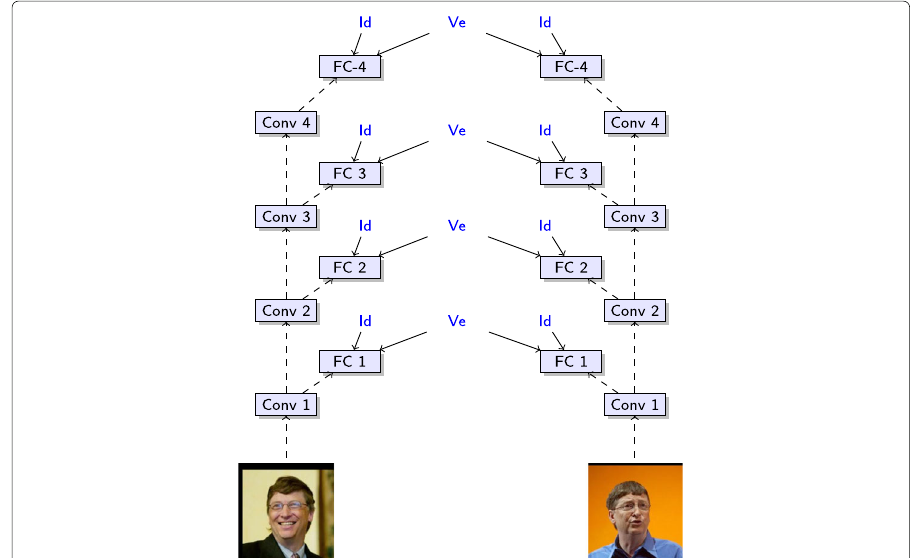
Fig. 7 DeepID2+ net. Conv n, n th convolutional layer (with max-pooling). FC n, n th fully connected layer. Id, identification supervisory signal. Ve, verification supervisory signal. Dashed arrows denote forward propagation. Solid arrows denote supervisory signals. Nets in the left and right are two DeepID2+ nets with shared weights and different input